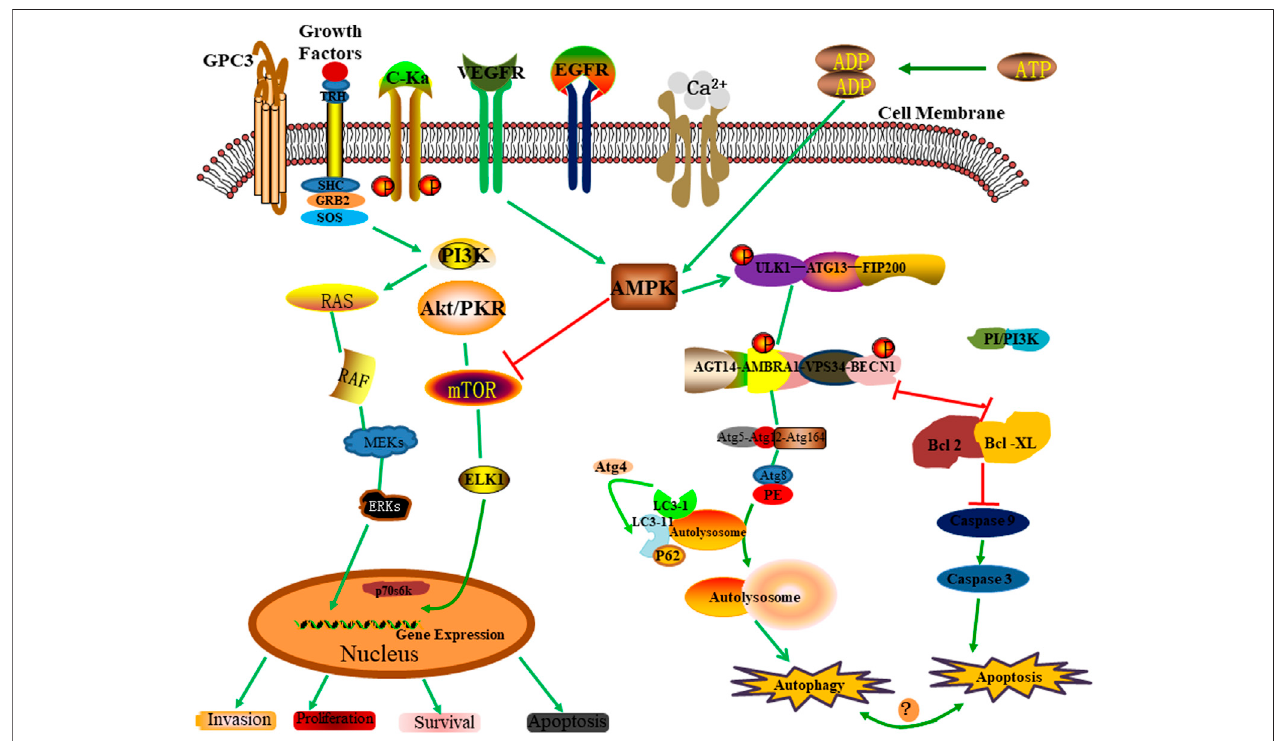
FIGURE 4 | Autophagy regulatory